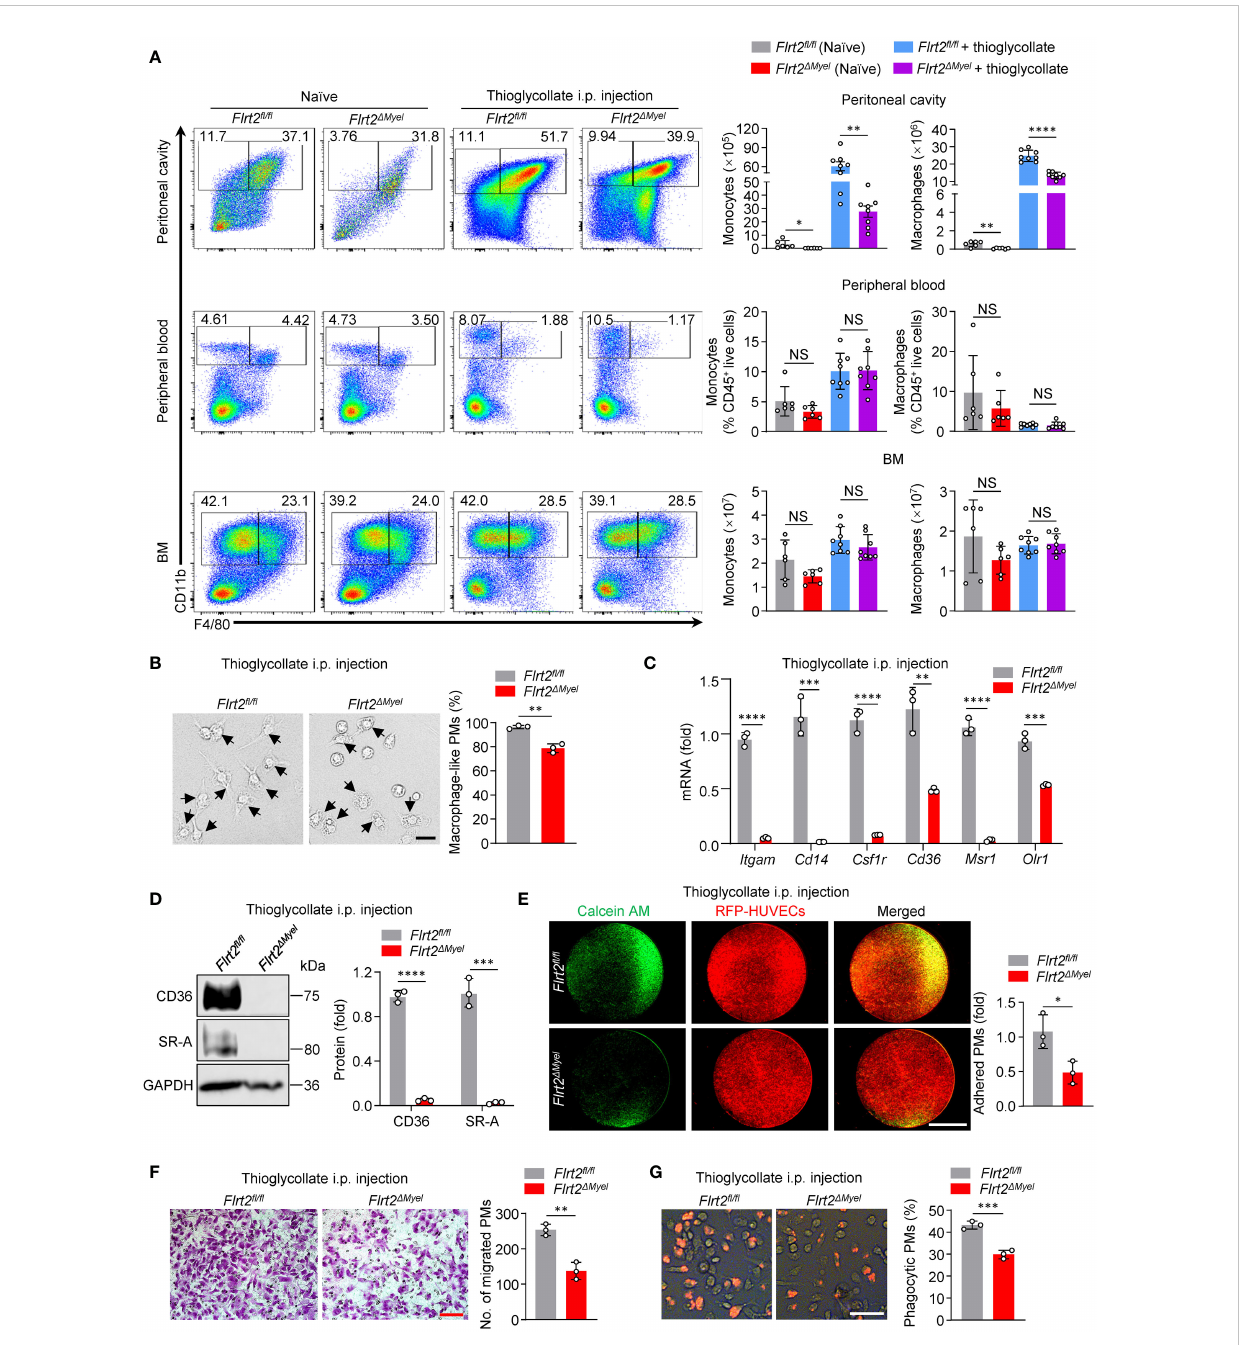
FIGURE 2 Myeloid cell-speci fi c FLRT2 knockout ( Flrt2 D Myel ) leads to decreased peritoneal monocyte-to-macrophage differentiation and impaired peritoneal macrophage functions in vivo . (A) Representative fl ow cytometric pro fi les and data plots showing the absolute numbers of CD45 + CD11b + F4/80 − monocytes and CD45 + CD11b + F4/80 + macrophages in the peritoneal cavity and BM, and the frequencies of CD45 + CD11b + F4/80 − monocytes and CD45 + CD11b + F4/80 + macrophages in peripheral blood of Flrt2 fl / fl and Flrt2 D Myel mice treated with or without i.p. injection of thioglycollate for 3 days (n = 6 or 8 mice per group). (B) Phase-contrast microscopy images showing morphological alterations of PMs isolated from Flrt2 fl / fl and Flrt2 D Myel mice (n = 3 mice per group). Scale bar, 50 m m. (C) qPCR analysis of Itgam , Cd14 , Csf1r , Cd36 , Msr1 , and Olr1 mRNA in PMs isolated from Flrt2 fl / fl and Flrt2 D Myel mice (n = 3 mice per group). (D) CD36 and SR-A protein levels in PMs isolated from Flrt2 fl / fl and Flrt2 D Myel mice were determined by immunoblot analysis (n = 3 mice per group). (E) PMs were collected from Flrt2 fl / fl and Flrt2 D Myel mice and then co-cultured with HUVECs expressing RFP for 6 h, followed by fl uorescent microscopy (n = 3 mice per group). Scale bar, 5 mm. (F) PMs were isolated from Flrt2 fl / fl and Flrt2 D Myel mice and seeded in a Boyden chamber for 48 h, followed by crystal violet staining (n = 3 mice per group). Scale bar, 100 m m. (G) Zymosan was injected i.p. into Flrt2 fl / fl and Flrt2 D Myel mice for 2 h, and PMs were collected and placed in a 6-well plate for 6 h. The phagocytic particles were observed under a laser confocal scanning microscope (n = 3 mice per group). Scale bar, 50 m m. Data are means ± SD. P values were determined using unpaired, two- tailed Student ’ s t -tests. NS, not signi fi cant. * P < 0.05, ** P < 0.01, *** P < 0.001, **** P <